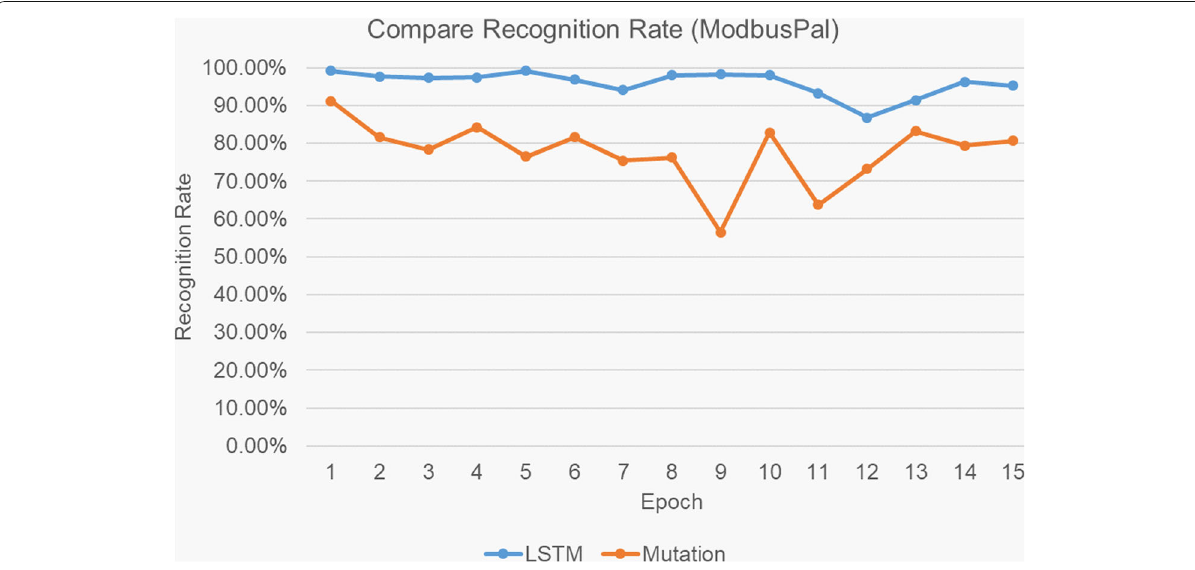
Fig. 11 The recognition rate of ModbusPal. The recognition rate of the data predicted by LSTM and using ModbusPal as the DUT